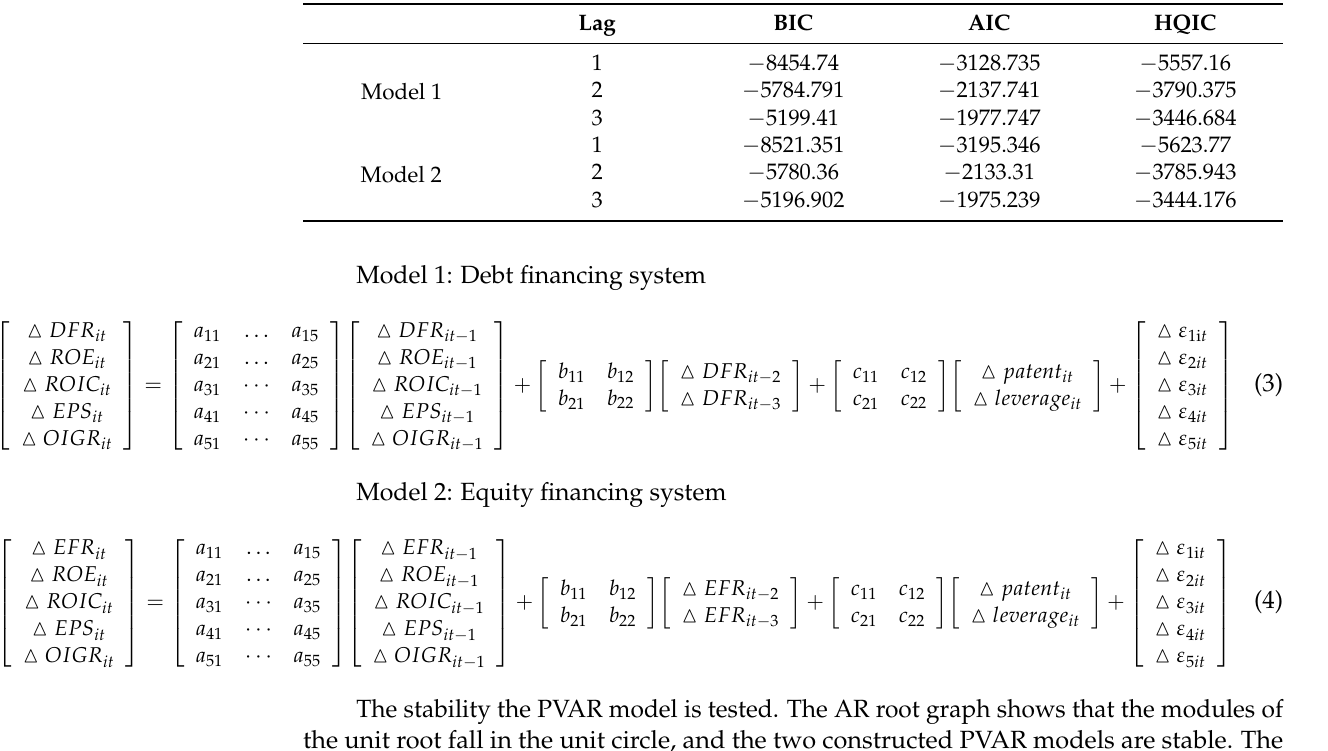
Table 3. The choice of lag order.